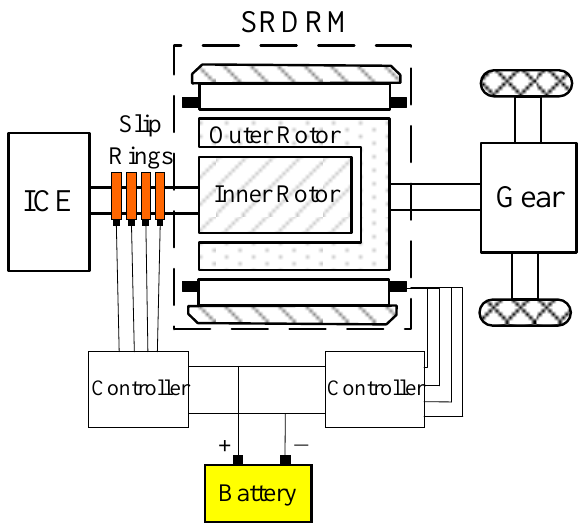
Figure 1. SRDRM in hybrid electric vehicle